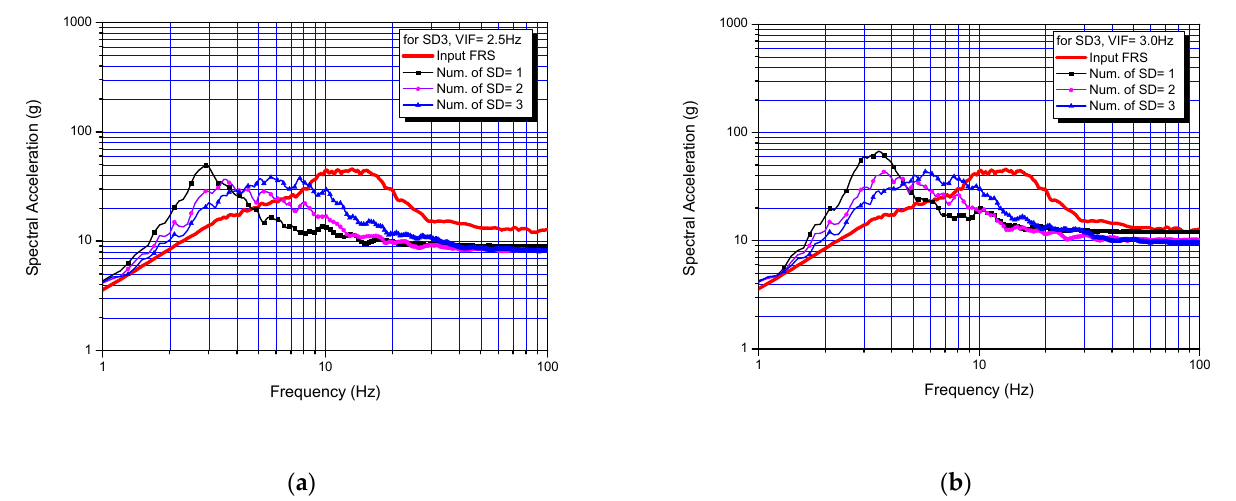
Figure 23. Results of vertical response spectrum for steel damper, SD3: ( a ) Design VIF = 2.5 Hz; ( b ) design VIF = 3.0 Hz. Table 13. Results of vertical seismic displacement responses of vertical isolation